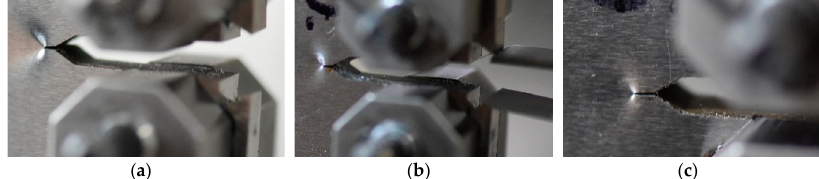
Figure 11. Variations of the crack propagation parameters: as a function of the cycle number for the parent material, weld and HAZ: ( a ) da/dN; ( b ) ∆ K.